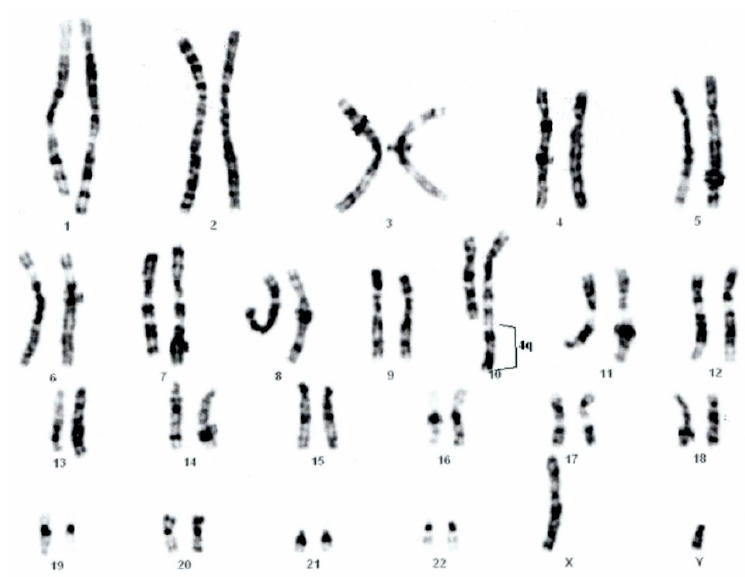
Figure 1. Cranio-facial aspect of the index case. GTG banding showed a 46,XY,der(10)(10pter → 10q26.2::4q26 → 4qter) chromosomal formula (Figure 2) that imposed parental karyotype. The father was normal, but the mother have a balanced reciprocal translocation between chromosomes 4 and 10: